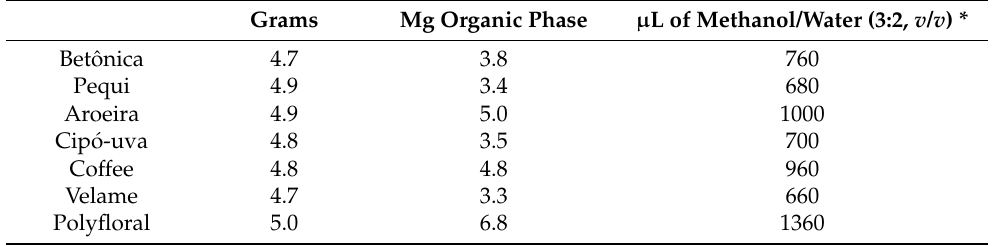
Table 9. Data for sample extraction and preparation.